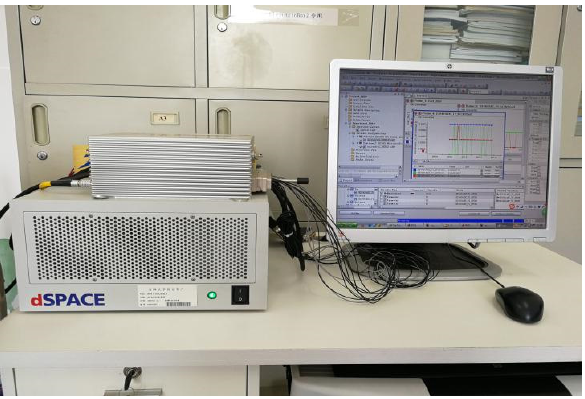
Figure 4. Hardware platform of the active collision avoidance control system.